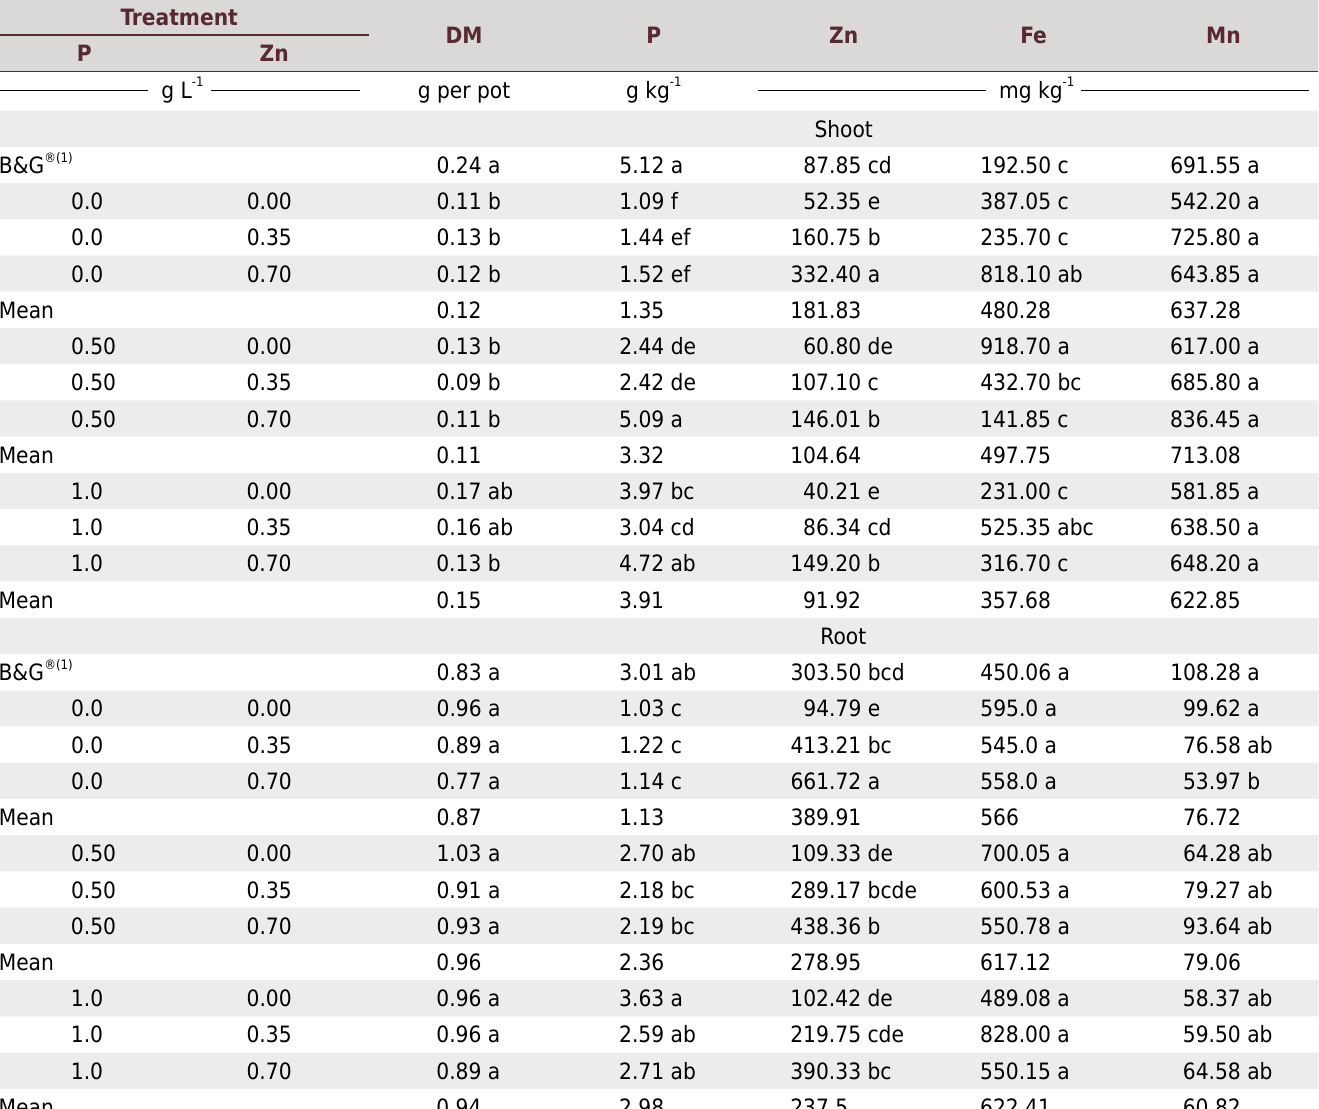
Table 1. Dry matter production (DM) of shoots and roots of phosphorus, zinc, iron, and manganese in Phalaenopsis spp., for different phosphorus and zinc application rates